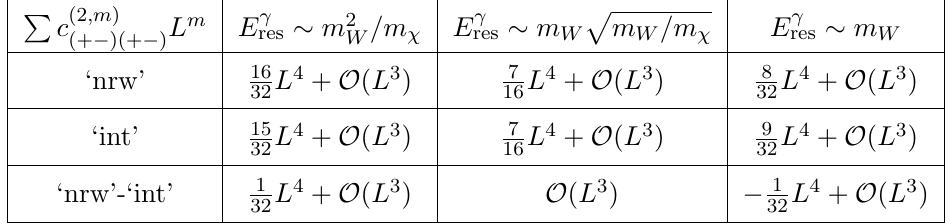
Table 2 . Leading-logarithmic terms of the two-loop coefficients in (5.3) for the ‘nrw’ and ‘int’ factorization formulas, and the difference of the two, at the scales relevant to figure